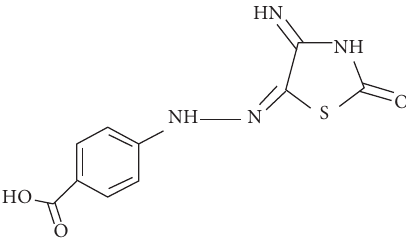
Figure 1: Structure of the 4-( N’ -(4-imino-2-oxo-thiazolidine-5- ylidene)-hydrazino)-benzoic acid.